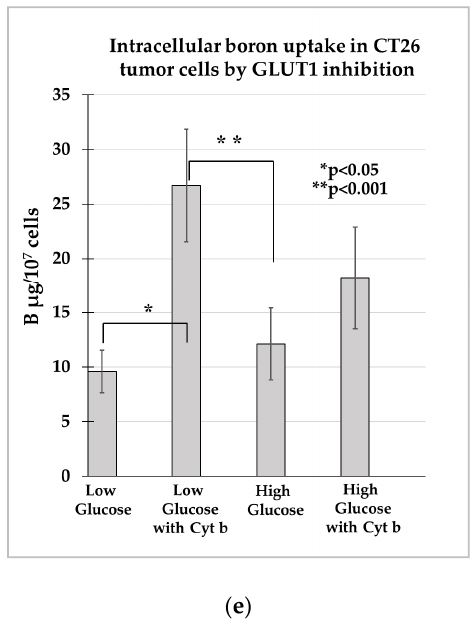
Figure 5. The intracellular uptake of MMT1242 among the different kinds of tumor cells lines. The intracellular uptake of MMT1242 resulting in high boron concentrations in the CT26 tumor cells ( a ), and in the different kinds of tumor cell lines ( b ). MMT1242 showing intracellular retention in CT26 tumor cells ( c ) The temperature dependence of intracellular boron uptake in CT26 tumor cells ( d ). Intracellular boron uptake in CT26 tumor cells by GLUT1 inhibition ( e ).